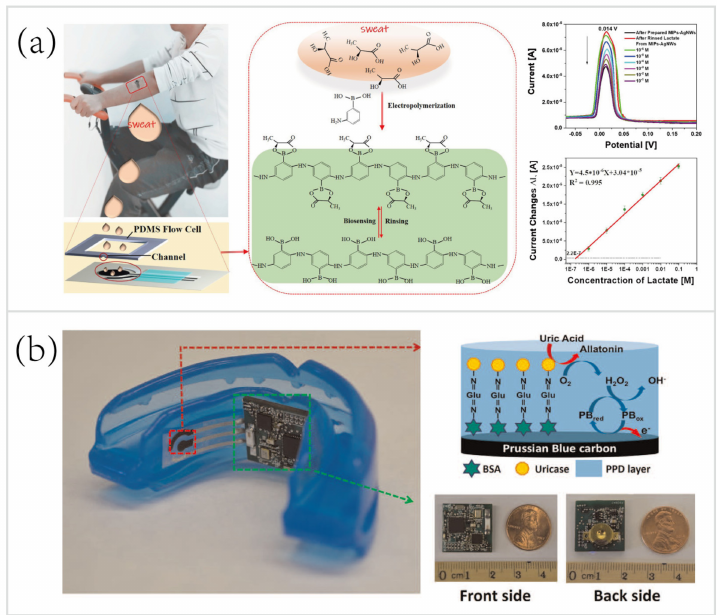
Figure 4. Wearable voltammetric / amperometric biosensors for sweat / saliva analysis. ( a ) A wearable voltammetric biosensor based on Ag nanowires (AgNWs) and molecularly imprinted polymers (MIPs) forinsitumonitoringoflactateinthehumansweat. Athree-electrodeMIPs-AgNWsbiosensormounting on the volunteer’s arm; the principle of MIPs’ formation and biosensing on the carbon working electrode; di ff erential pulse voltammetry (DPV) responses and the calibration curve of MIPs-AgNWs biosensor for detection of lactate [127]. Copyright 2020, Elsevier. ( b ) A wearable amperometric mouthguard biosensor for real-time continuous salivary uric acid detection, screen printed uricase carbon working electrode, and its fabricated printed circuit board assembly (PCBA) [58]. Copyright 2015,